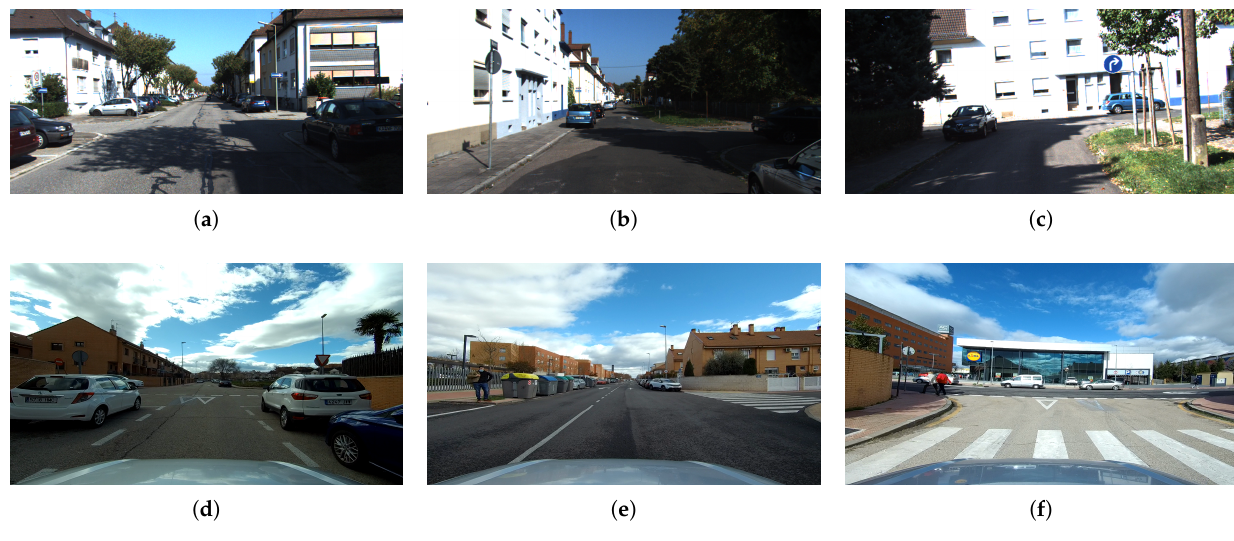
Figure 3. Some examples from the mid-sized city of Karlsruhe for the KITTI and KITTI-360 datasets and Alcalá de Henares (our dataset). The reader can appreciate the differences in the spatial distribution of street elements with respect to Figure 1, as well as the change in the field-of view between the KITTI cameras ( a – c ) and our dataset ( d – f